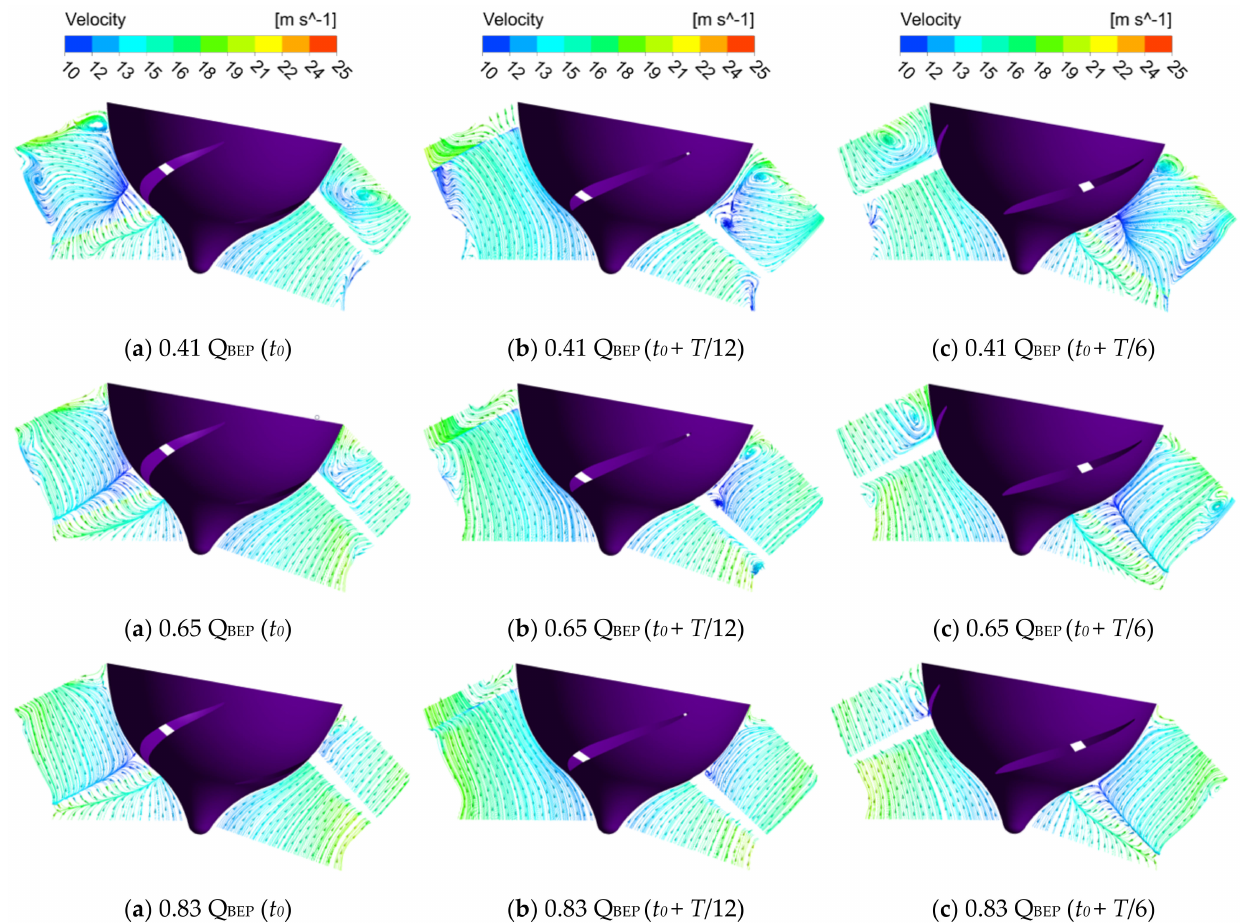
Figure 10. Streamlines colored according to velocity within the runner for different flow conditions at different